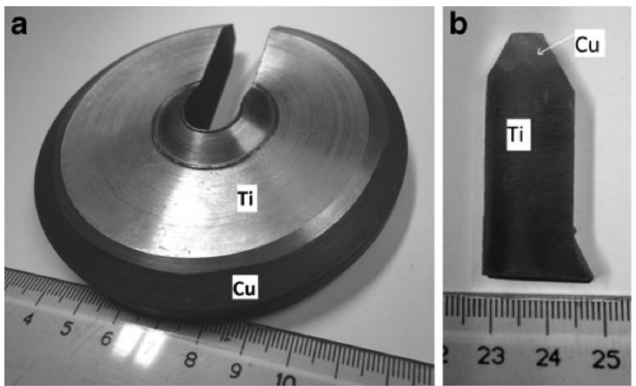
Figure 17. ( a ) Multilayer Ti ‐ Cu object and ( b ) its cut fragment fabricated by convenient cold spray system. Surface of part was machined by turning after cold spray deposition [62].